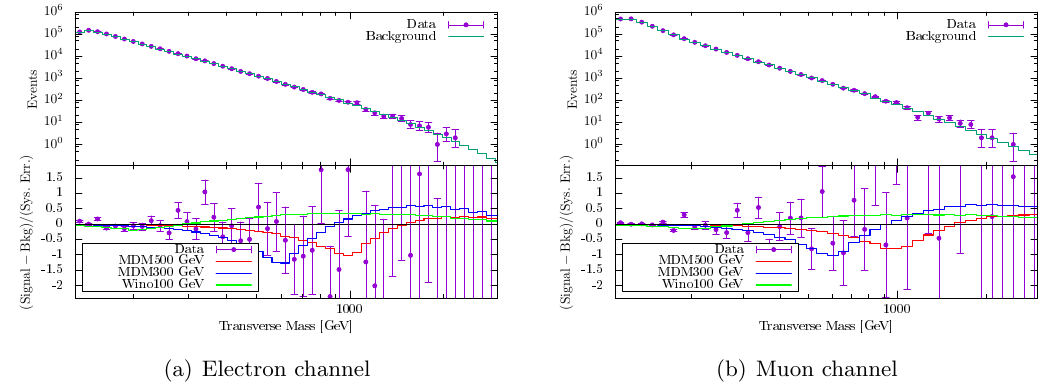
Figure 4 . The observed data and background of the transverse mass distribution at the ATLAS detector with 13 TeV running and integrated luminosity 36 fb (cid:0) 1 [55]. In the lower panel, we show the pull of the data from the background and the EWIMP signatures of the 100 GeV Wino and 300 GeV and 500 GeV 5plet Majorana fermion (MDM).